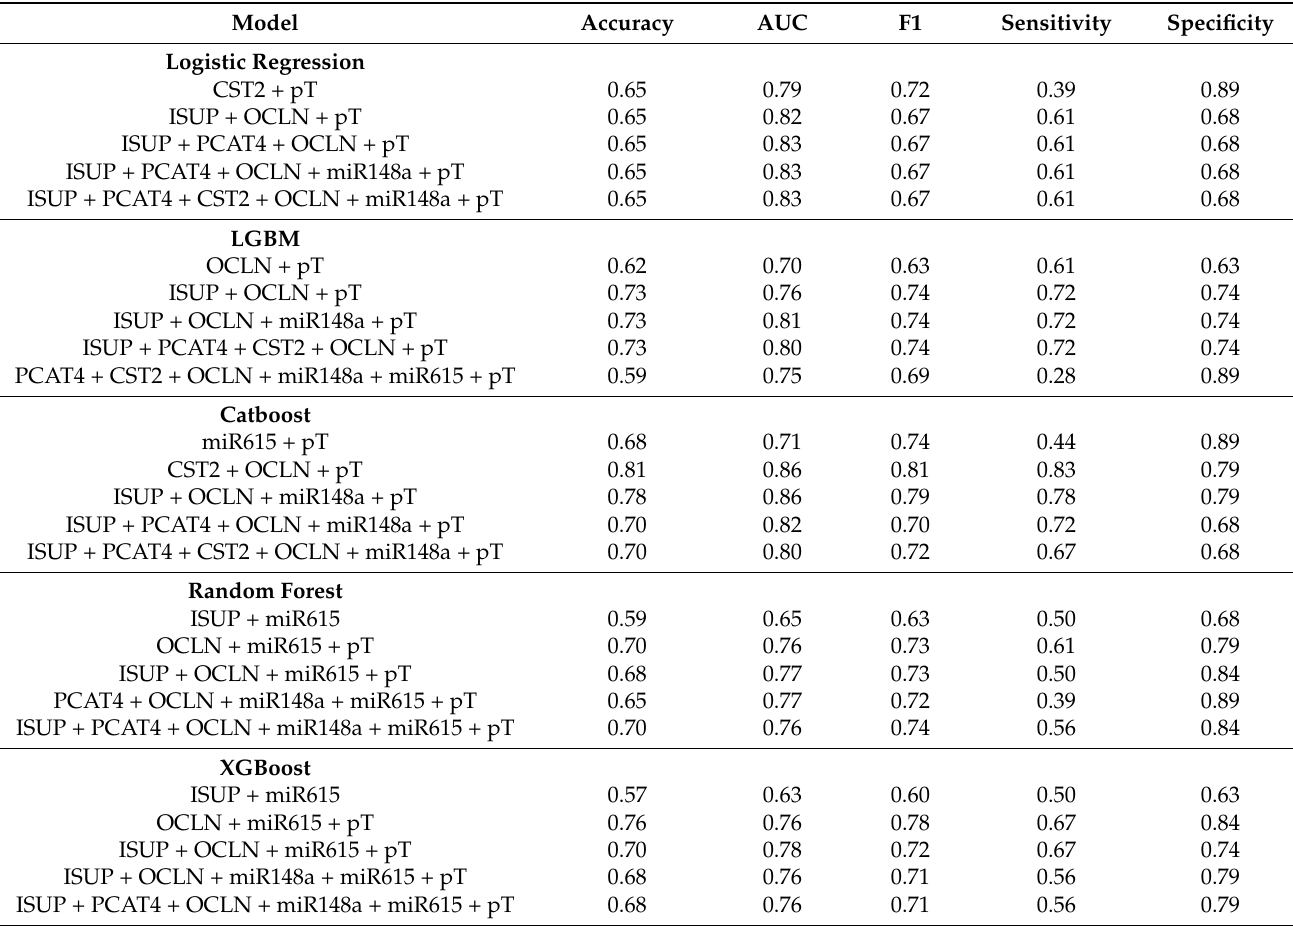
Table 4. The best models by AUC in each category of predictor combinations based on Logistic Regression, LGBM, Catboost, Random Forest, and XGBoost